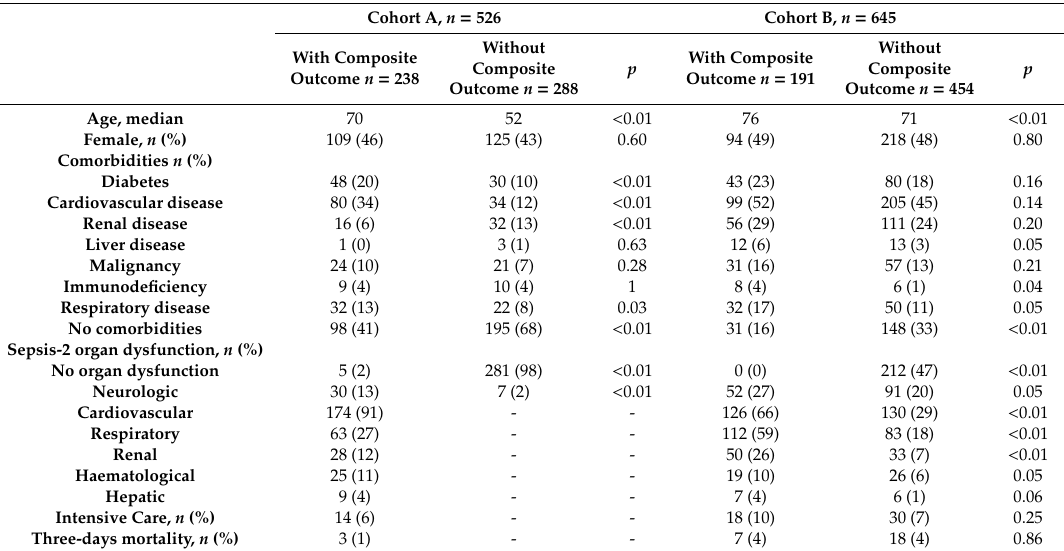
Table 2. Patient characteristics. Percentages within